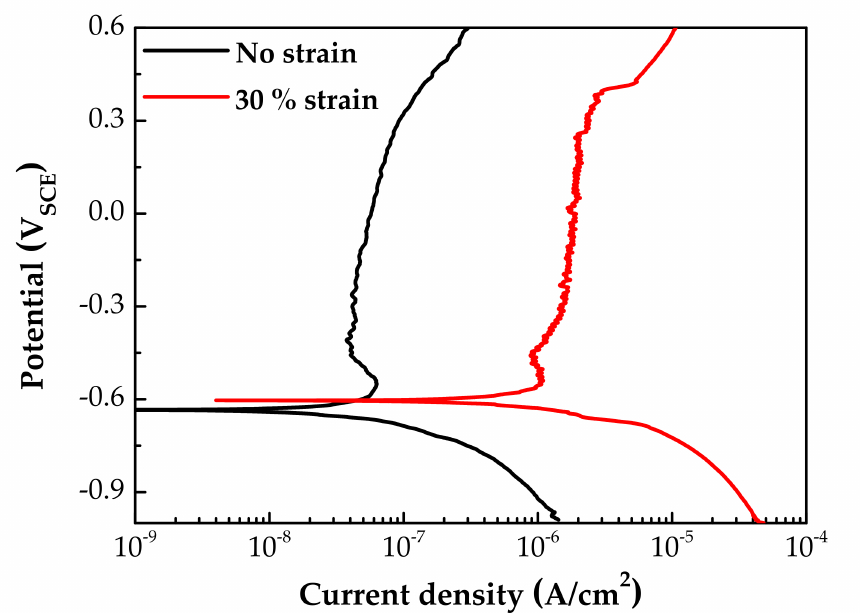
Figure 7. Potentiodynamic polarization curves of fresh Alloy 600 specimens with and without 30% tensile strain.